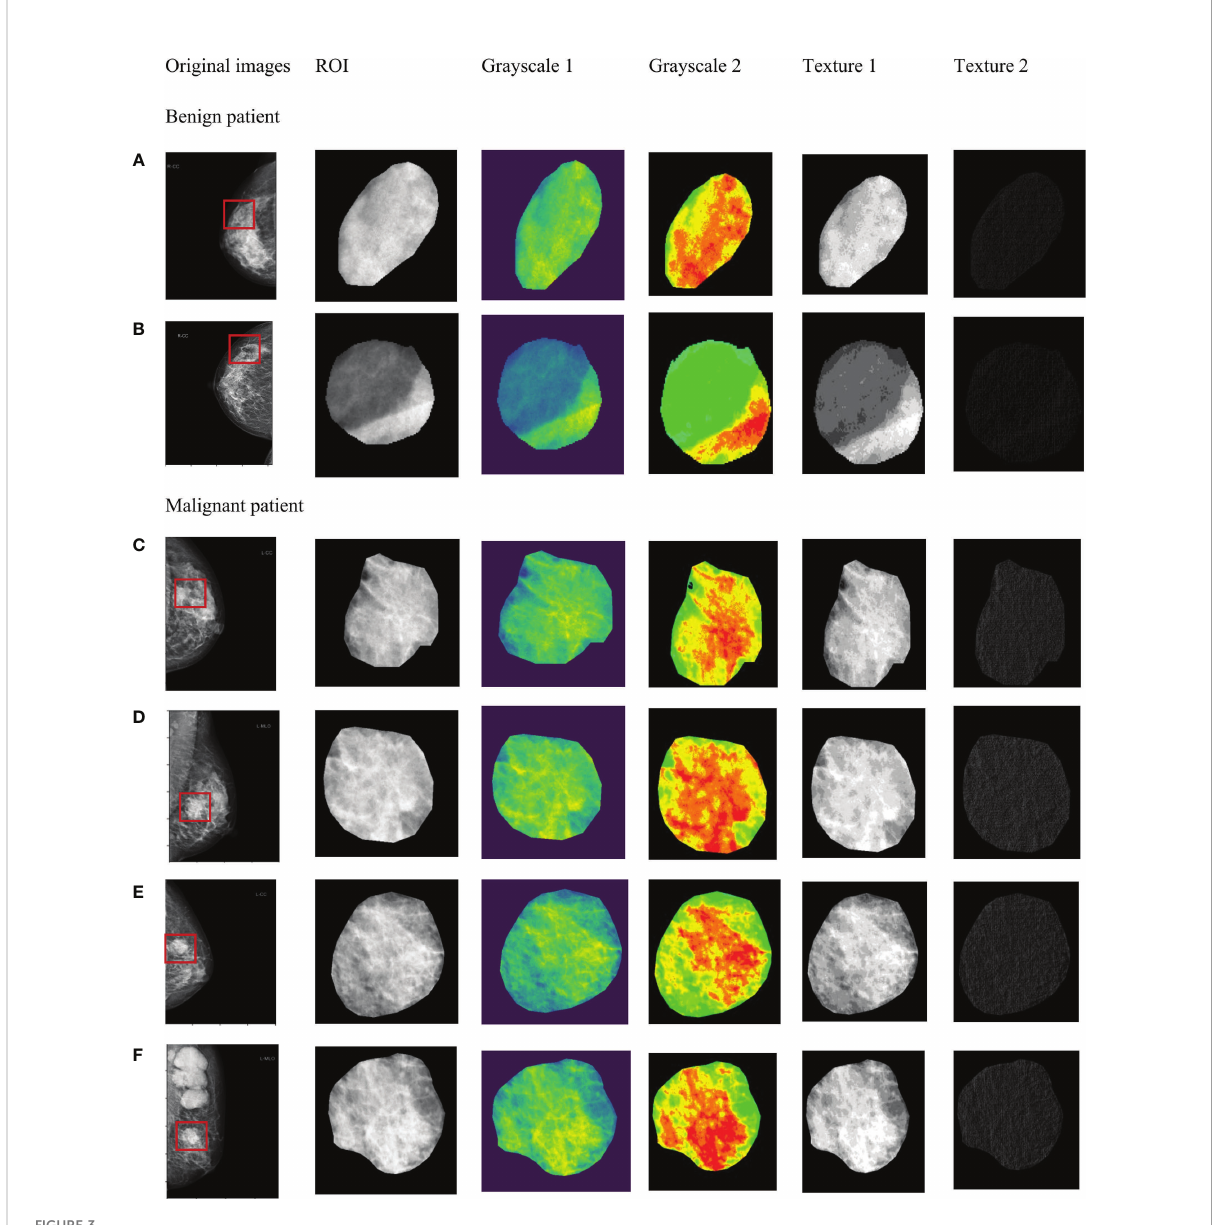
FIGURE 3 Signi fi cant radiomics features of masses in tumor ROI. Benign masses (A, B) . Malignant masses (C – F)